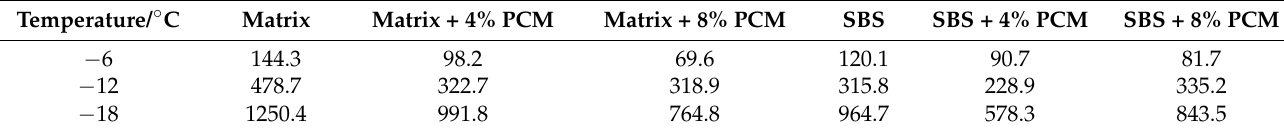
Table 3. The results of St/m at 60 s of test